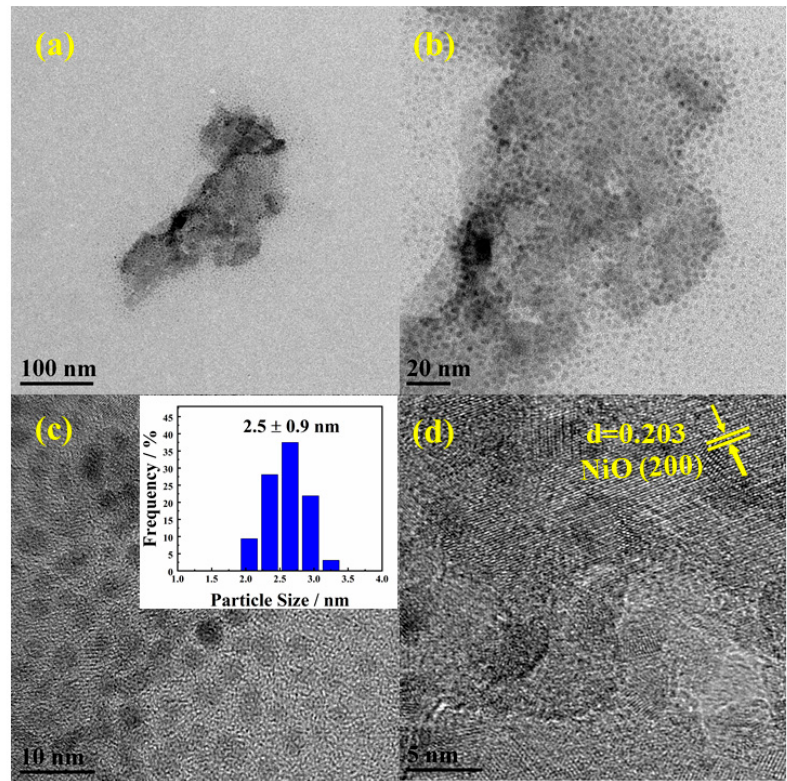
Figure 5. TEM and HRTEM images of AE-NiO/ γ -Al 2 O 3 catalyst, ( a – d ) are images under the different scales.